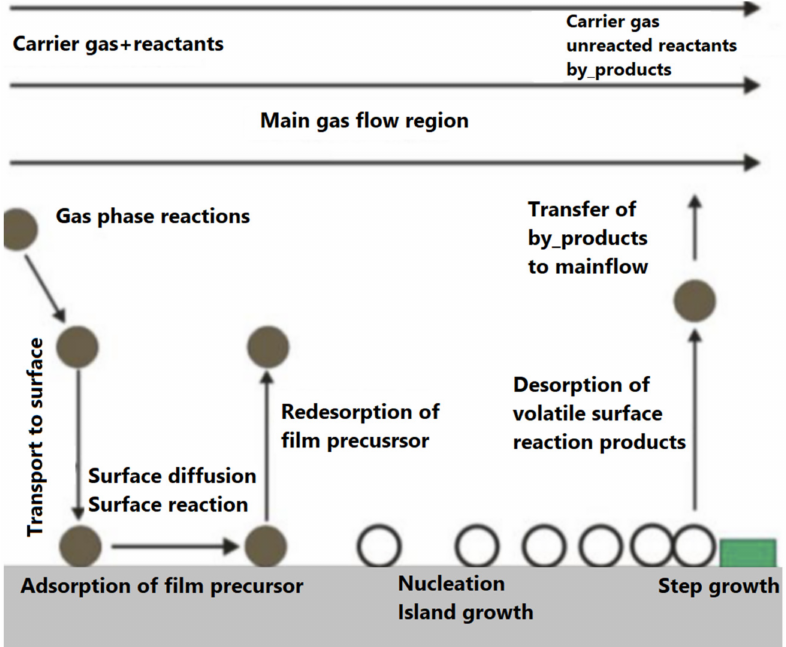
Figure 7. Schematic of the growth mechanism of CVD. Reprinted with permission from [47]. CVD can deposit metal oxides on a variety of substrates, including SiO 2 , Al 2 O 3 , and ITO [50,51]. However, growth is influenced by factors such as substrate